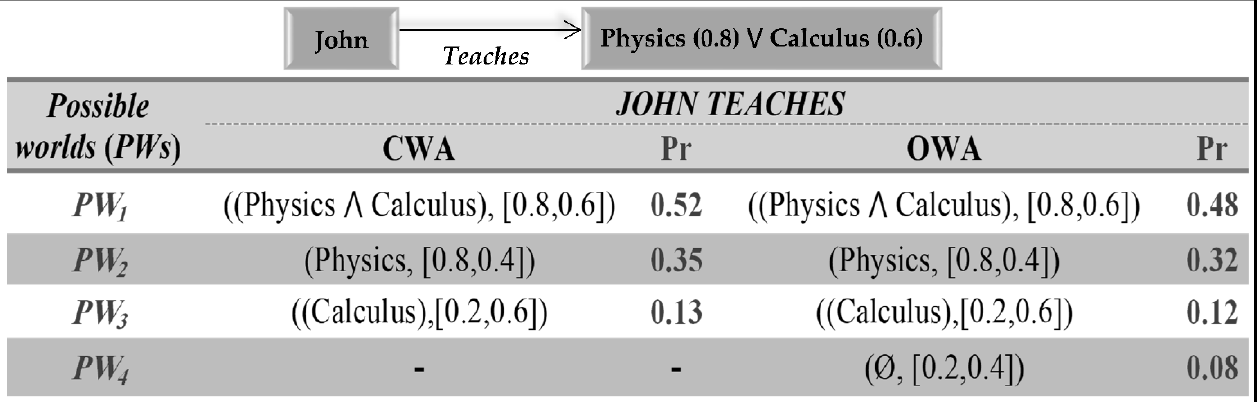
Figure 3. Possible world’s example with associated probability values .